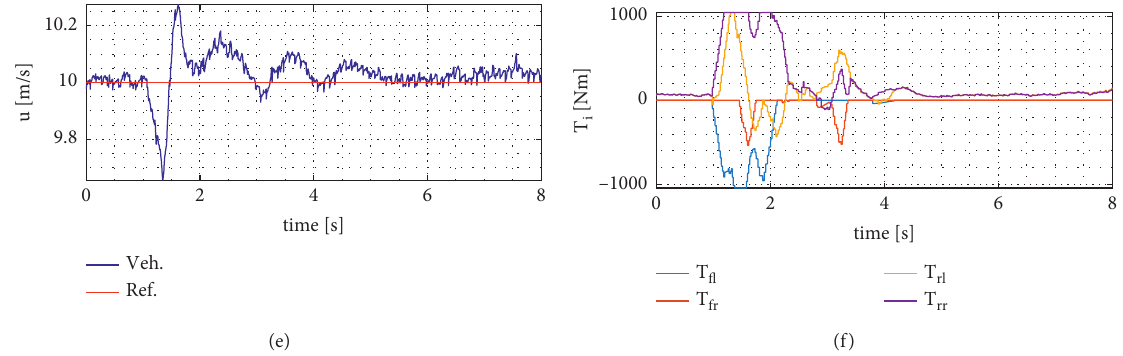
Figure 12: Override handling using cost function g D . (a) Path. (b) Heading. (c) Yaw rate. (d) Road-wheel angle. (e) Longitudinal velocity. (f) Wheel